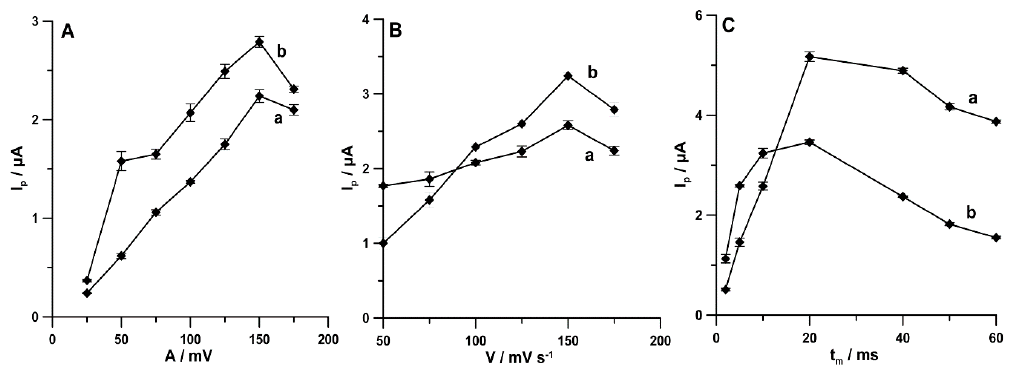
Figure 8. E ff ect of ( A ) A (25–170 mV), ( B ) ν (50–175 mV s − 1 ), and ( C ) t m (2–60 ms) on PA (1.0 × 10 − 6 mol L − 1 ) and DF (1.0 × 10 − 8 mol L − 1 ). The DPAdSV parameters are as follows: E acc. of 0.1 for 1 s and − 0.25 V for 1 s, n cycles = 30, ν of 175 mV s − 1 , and t m of 10 ms ( A ); A of 150 mV and t m of 10 ms ( B ); and A of 150 mV and ν of 150 mV s − 1 ( C ).